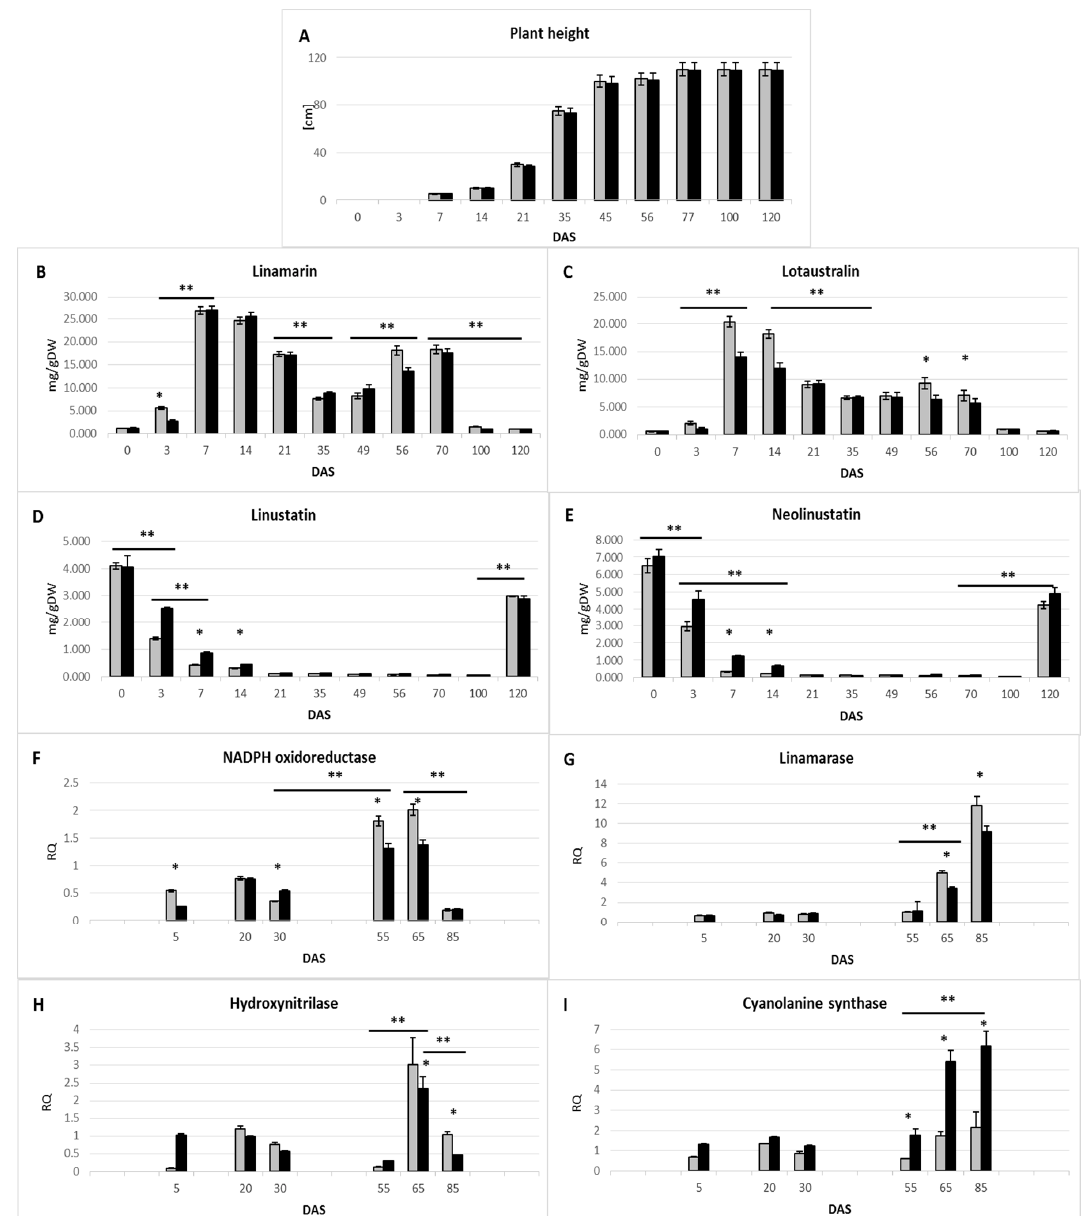
Figure 2. Fluctuation in cyanogenic glucoside levels and expression of GC metabolism genes during plant growth in control and Met25 expressing plants (comparison). Plant growth in height ( A ); fluctuation of cyanogenic monoglucoside level ( B , C ); fluctuation of cyanogenic diglucoside level ( D , E ); the mRNA level of GC metabolism genes: NADPH oxidoreductase ( F ), linamarase ( G ), β -cyanoalanine synthase ( H ) and hydroxynitrilase ( I ) obtained from the real-time RT-PCR analysis. DAS, days after sowing; RQ, relative quantity. Data represent the mean ± standard deviations from at least three independent experiments. Data constitute the mean value ± SD from at least three technical repeats of three independent biological samples. The significance of the differences between the transgenic plant and control was determined by Student’s t-test. Asterisk indicates p < 0.05. For an indication of developmental changes, the ANOVA test was used— p value = 0.001 was indicated by asterisks and the line indicates the compared data range.